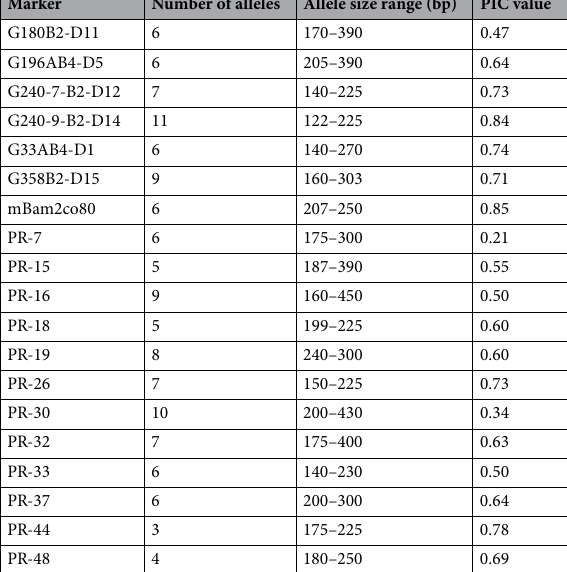
Table 3. SSR marker, allele number, sizes and polymorphic information content.